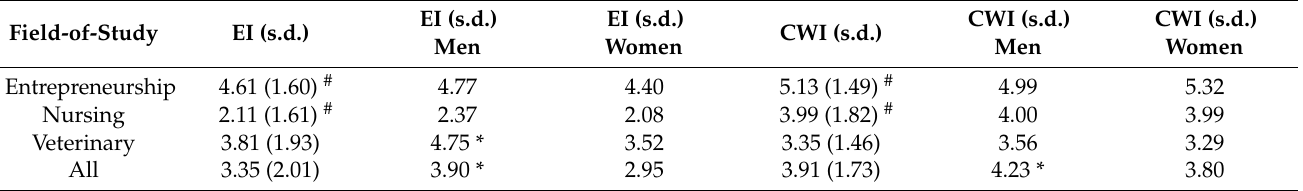
Table 4. Means and standard deviations of entrepreneurial and corporate work intention by field-of- study and gender (n = 515).